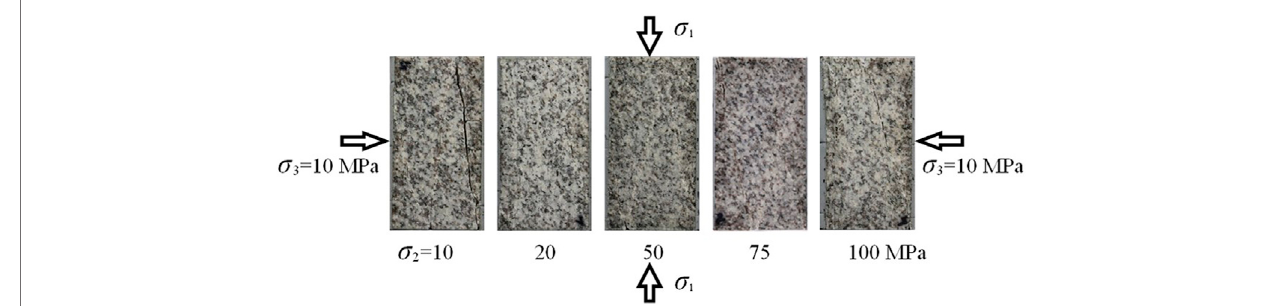
FIGURE 7 | Failure modes of tested granite change with σ 2 when σ 3 is 10 MPa.